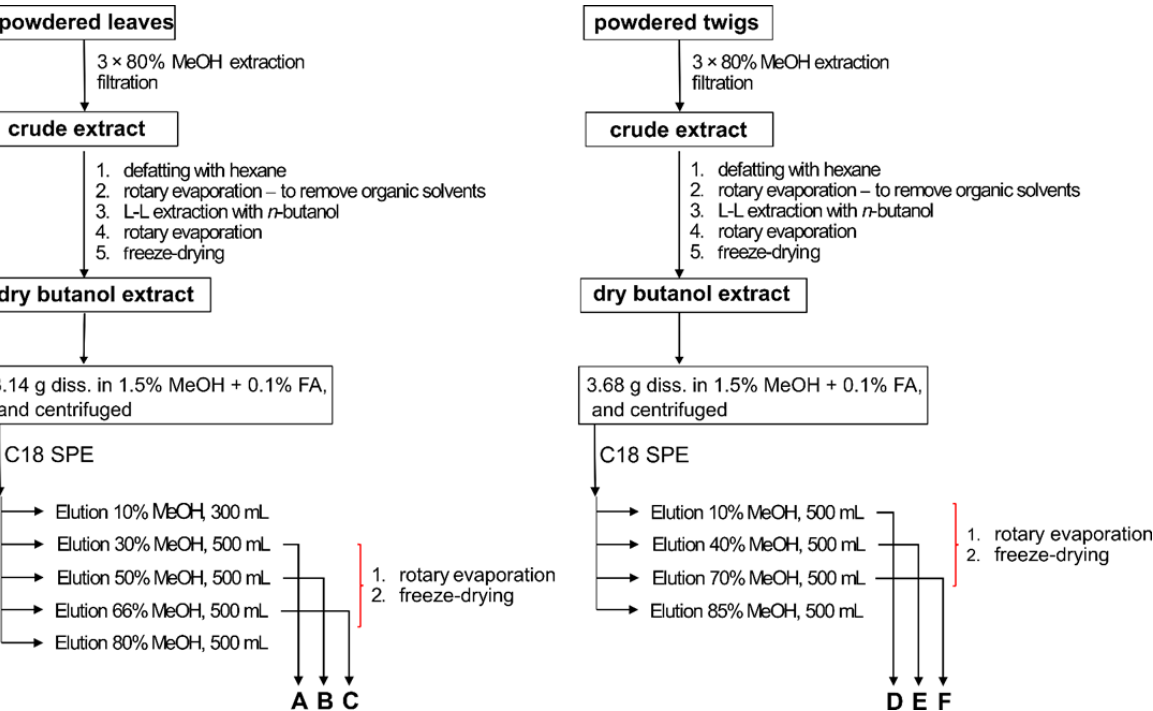
Figure 6. A diagram of methods of extraction and fractionation applied to obtain the investigated phenolic preparations of sea buckthorn leaf extract ( A – C ) and twig extract ( D – F ).